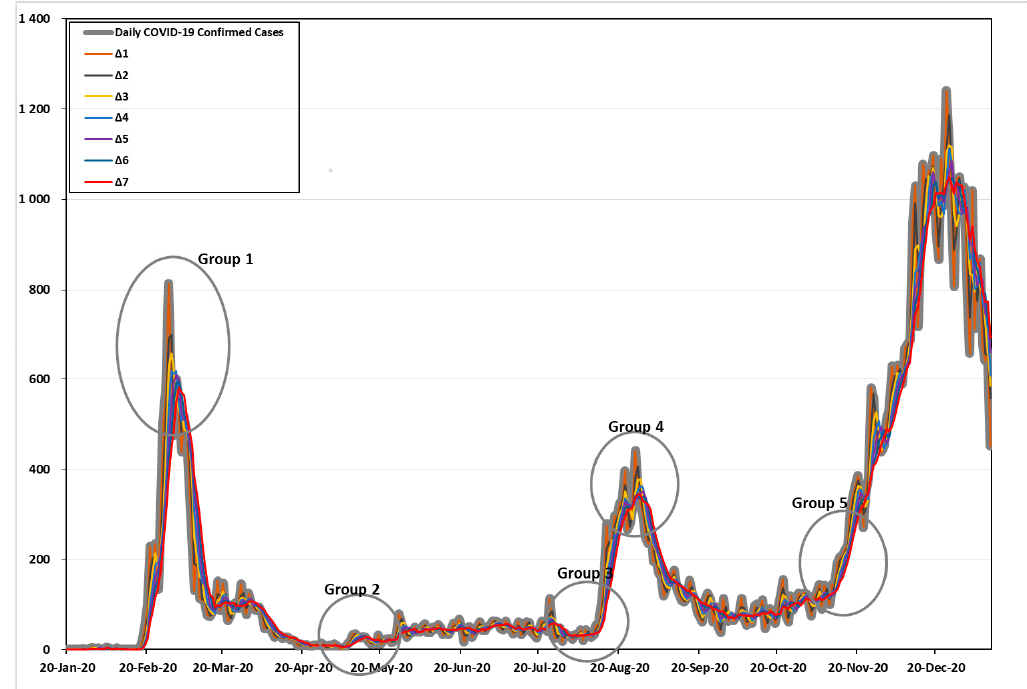
Figure 2. The increasing number of confirmed cases of COVID ‐ 19 by time interval. Table 1. The number of confirmed cases of COVID ‐ 19 during time interval ∆ t by Group. Group